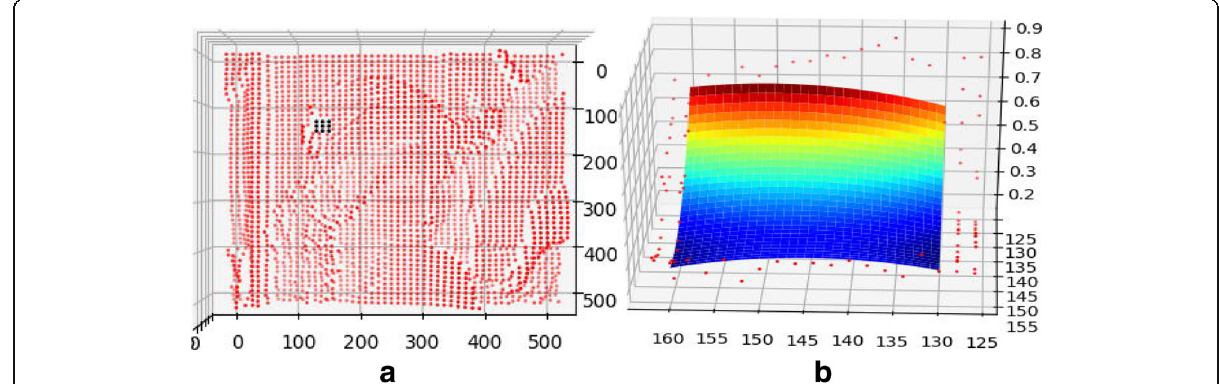
Fig. 4 Visualization of the damaged image called ‘ Lena. ’ a The point cloud from image to 3D subspace. b The fitting surface using